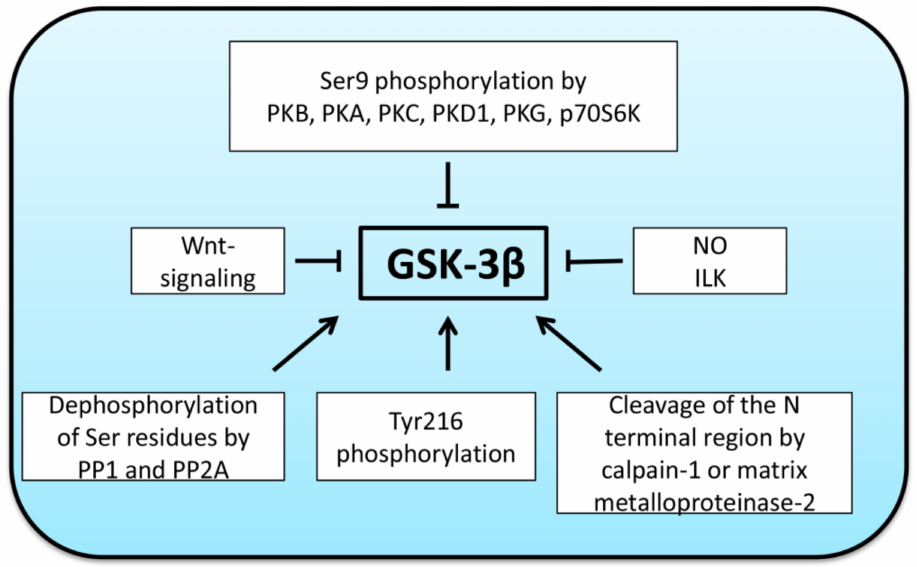
Figure 1. Positive and negative regulators of GSK-3 β activity. Notably, apart from regulators showed in the figure, GSK-3 β activity can also depend upon subcellular localization and protein-protein interactions. PKA—protein kinase A, PKA— protein kinase B (AKT), PKC—protein kinase C, PKD1—protein kinase D1, PKG—protein kinase G, p70S6K—ribosomal protein S6 kinase, NO—nitric oxide, ILK—integrin-linked kinase, PP1 and PP2A—protein phosphatases 1 and